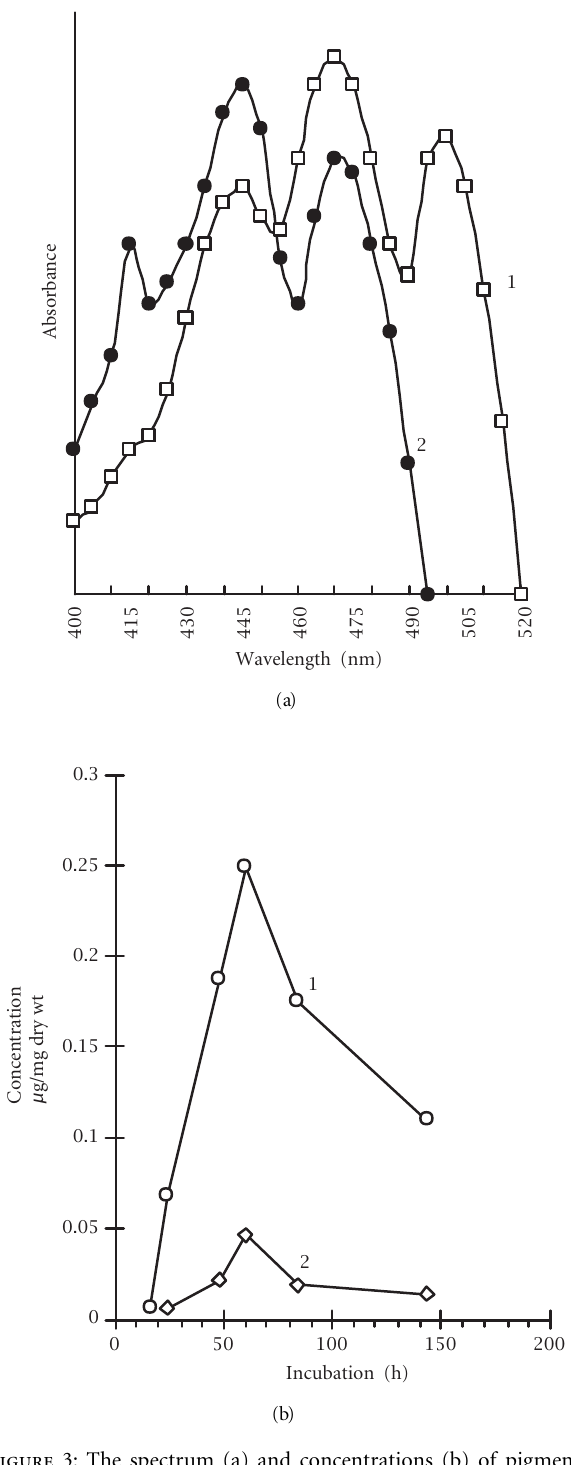
Figure 3: The spectrum (a) and concentrations (b) of pigments extracted from E. coli containing pC51 . Symbols; 1, lycopene; 2,